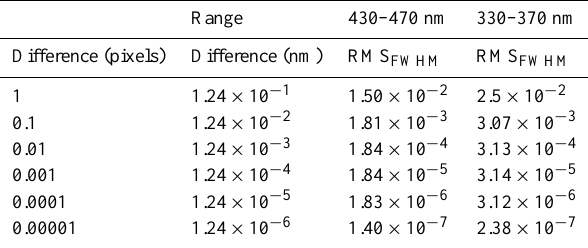
Table 2. Calculated RMS dependence on symmetric line shape broadening (Gaussian line